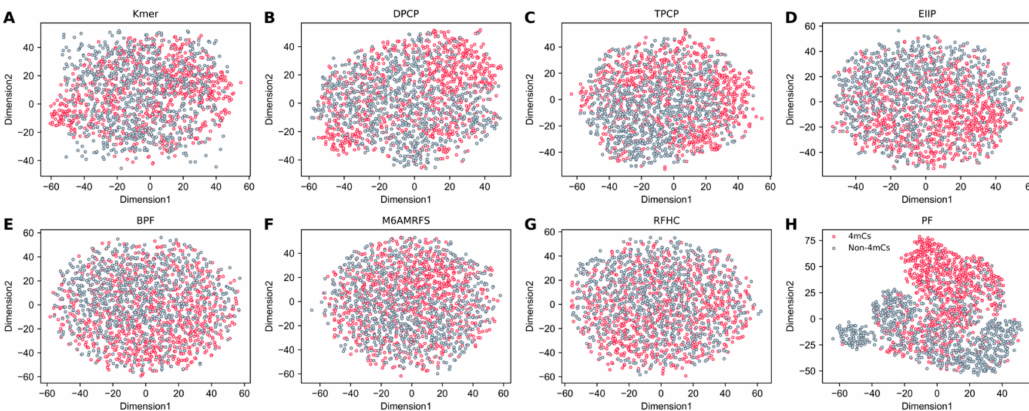
Figure 5. t-SNE visualization of the benchmark dataset in a two-dimensional feature space. Gray- and red-colored circles indicate non-4mCs and 4mCs, respectively. ( A ) Kmer, ( B ) dinucleotide (DPCP), ( C ) trinucleotide-physicochemical properties (TPCP), ( D ) EIIP of trinucleotides, ( E ) binary profile (BPF), ( F ) M6AMRFS, ( G ) ring-function-hydrogen-chemical properties (RFHC), and ( H ) the 28